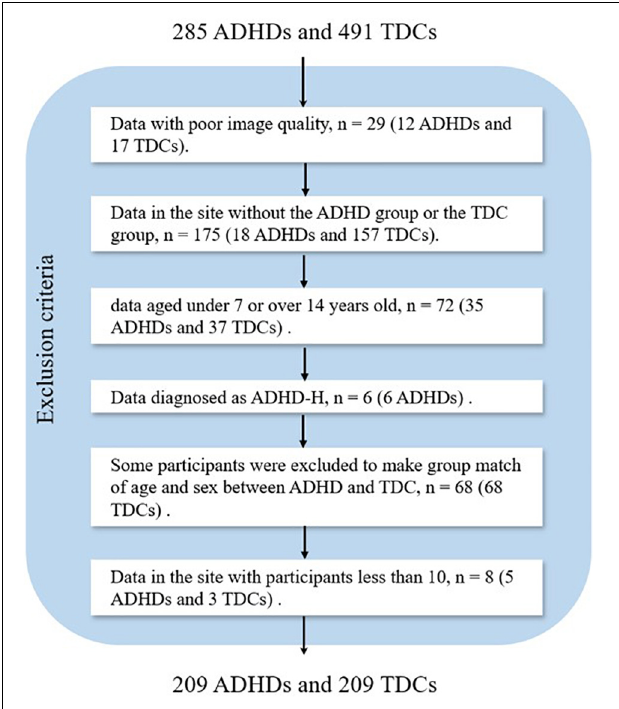
FIGURE 1 | Flowchart of data exclusion for ADHD-200 (ADHD, attention deficit hyperactivity disorder; TDC, typically developing control